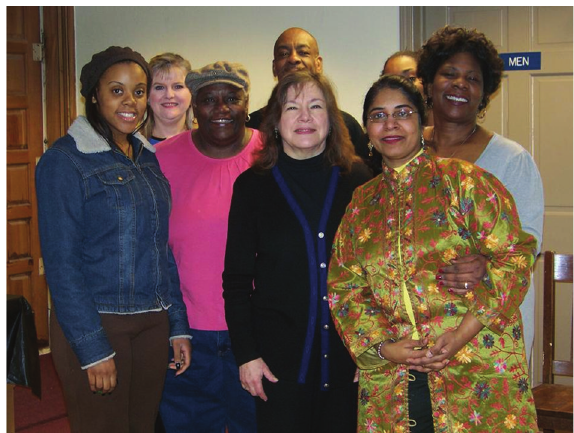
Figure 1: HEALS Team with CHCs (from left to right front row). Alexis Belcher (CHC), Ivey Brown (CHC) Catherine Champagne (study Co-I), and Sunita Dodani Debra Sullivan (study PI). Back row: Debra Sullivan (study Co-I), Thaerius Berry (CHC), Sydny Pankey (study coordinator), and Vera Brown (CHC).